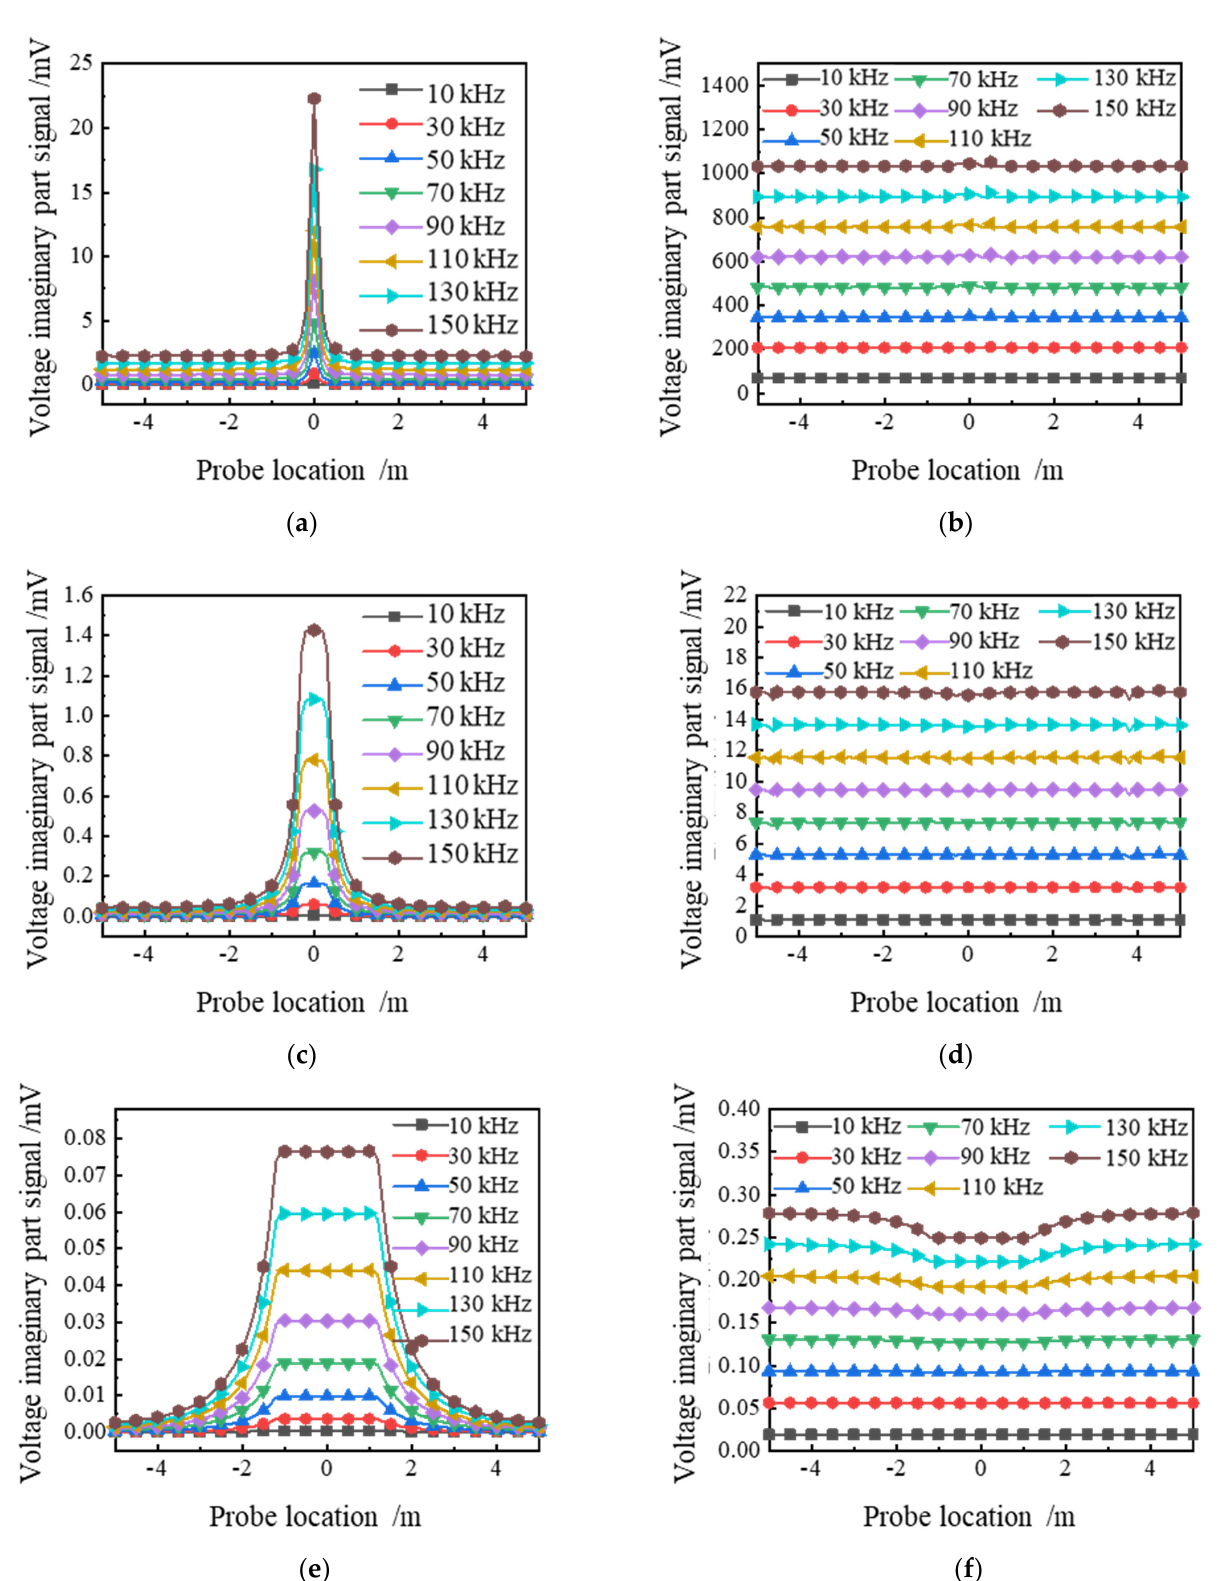
Figure 7. Electromagnetic signal response curves under different frequencies: ( a ) real part signal of subarray 1; ( b ) imaginary part signal of subarray 1; ( c ) real part signal of subarray 4; ( d ) imaginary part signal of subarray 4; ( e ) real part signal of subarray 7; ( f ) imaginary part signal of subarray 7.